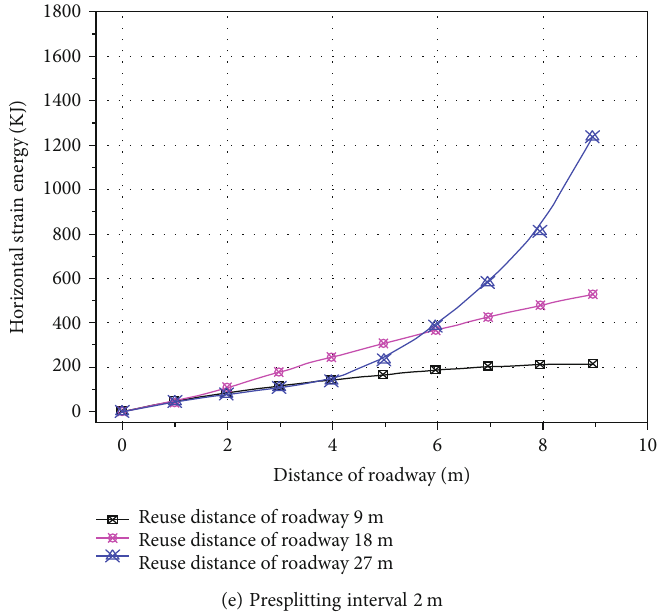
Figure 7: Strain energy accumulation and dissipation curve of presplitting fi ssure